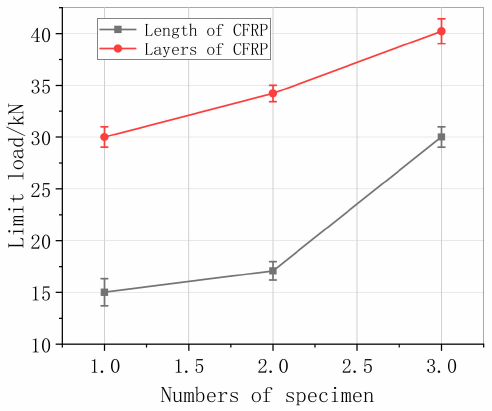
Figure 6. Loading of the CFRP parameters.